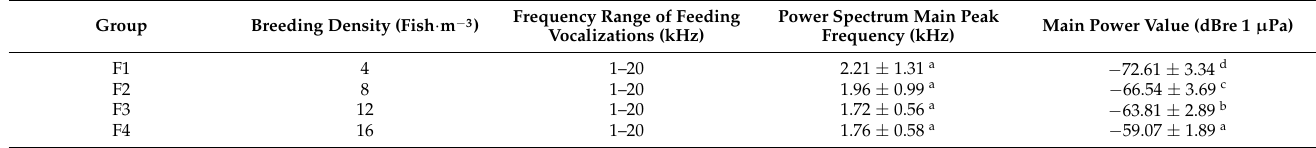
Table 2. Statistical characteristic values of power spectrum of largemouth bass at different culture